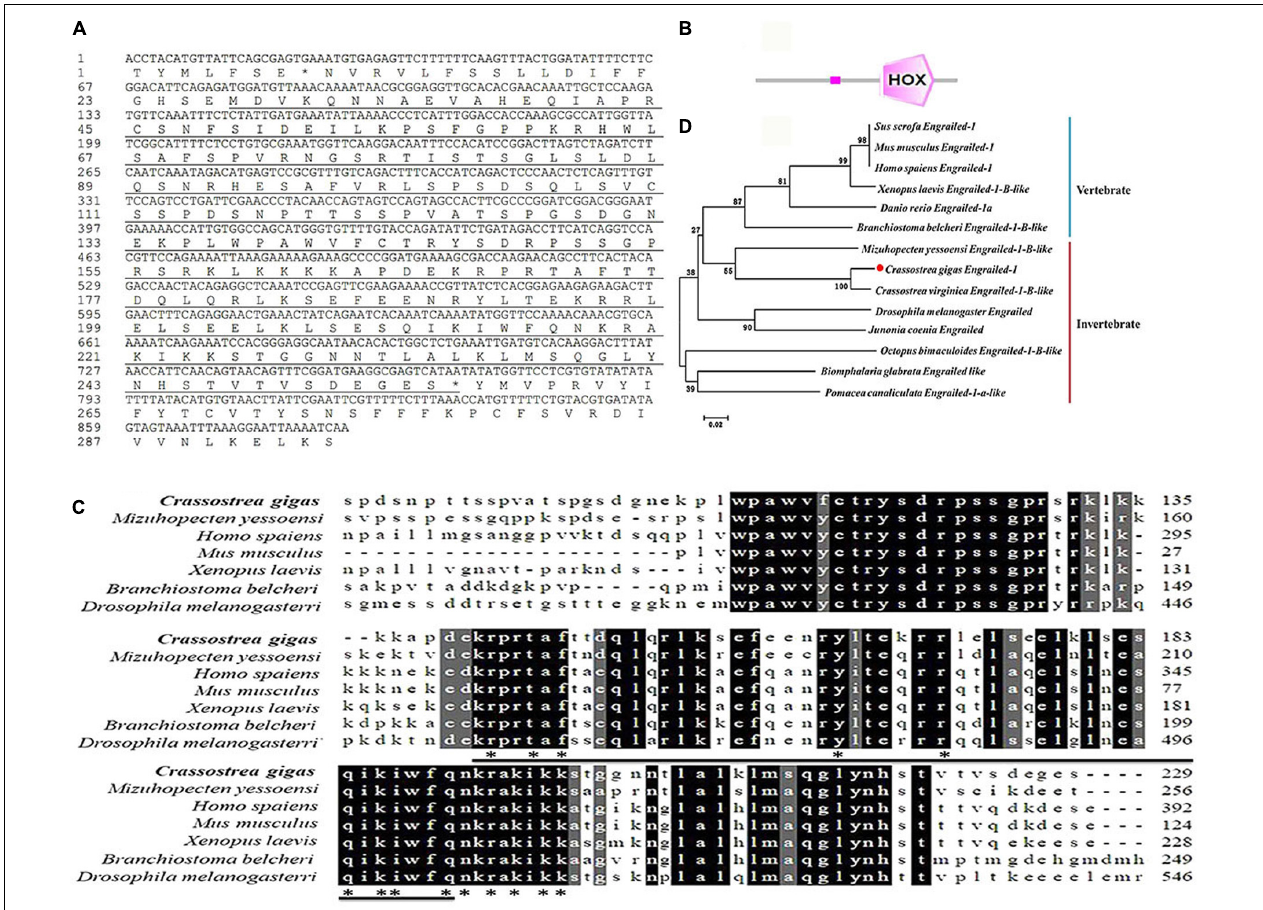
FIGURE 1 | Bioinformatics analysis of Cg engrailed-1. (A) The cDNA sequence and the putative protein of Cg engrailed-1 which is marked by black underline. (B) The typical HOX domain predicted by SMAT analysis. (C) Multiple sequence alignment of the Cg engrailed-1. Multiple sequence alignment of Cg engrailed-1 with known engraileds from various species including C. gigas (XP_011414452.1), M. yessoensi (XP_021372813.1), Homo sapiens (NP_001417.3), Mus musculus (NP_034263.2), Xenopus laevis (XP_018094123.1), Branchiostoma belcheri (XP_019636788.1), and Drosophila melanogaster (NP_523700.2). (D) Phylogenetic analysis of Cg engrailed-1. Fourteen engrailed sequences from different species were obtained from GenBank on NCBI, including Sus scrofa (XP_003133330.2), Mus musculus (NP_034263.2), Homo sapiens (NP_001417.3), Xenopus laevis (XP_018094123.1), Danio rerio (NP_571120.2), Branchiostoma belcheri (XP_019636788.1), M. yessoensi (XP_021372813.1), C. gigas (XP_011414452.1), C. virginica (XP_022294249.1), Drosophila melanogaster (NP_523700.2), Junonia coenia (AAD08923.1), Octopus bimaculoides (XP_014774611.1), Biomphalaria glabrata (XP_013080601.1), and Pomacea canaliculata (XP_025083924.1). ClustalX software was used to perform the multiple sequence alignment of the fourteen engrailed sequences. The neighbor-joining (NJ) tree of Cg engrailed-1 was constructed with Mega 6.0 software.